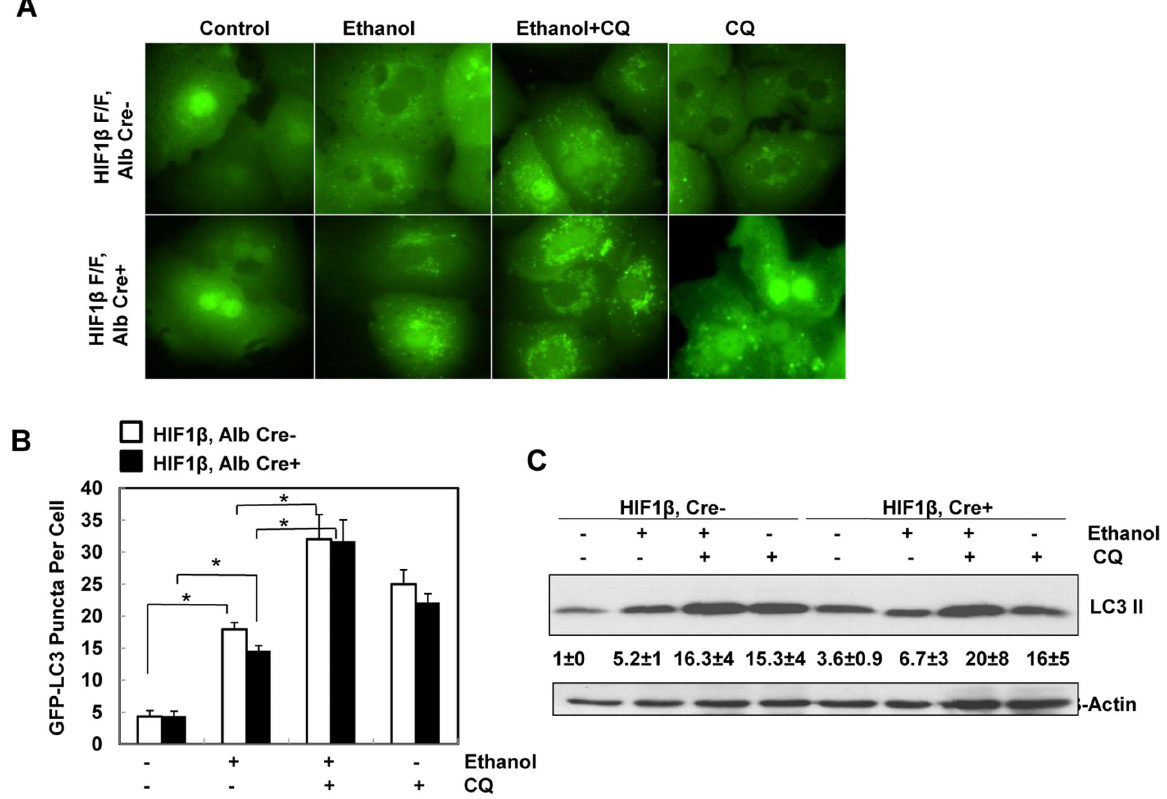
Fig. 3. Ethanol induced autophagic flux in primary mouse hepatocytes independent of HIF-1 b . Primary cultured wild type and HIF-1 b knockout mouse hepatocytes were infected with Ad-GFP-LC3 (100 viral particles per cell) overnight followed by ethanol (80 mM) treatment with or without CQ (20 m M) for 6 hours. ( A ) Representative fluorescence images of GFP-LC3 from each group are shown. ( B ) The number of GFP-LC3 puncta per cell was quantified (more than 20 cells were counted from each independent experiment) and data are presented as means ¡ SE (n 5 3 independent experiments). * p , 0.05. One way ANOVA analysis with Scheffe´’s post hoc test. ( C ) Cells were treated as in ( A ), total cell lysates were subjected to western blot analysis. Densitometry was performed and data are presented as a ratio of HIF-1 b , Alb Cre- control (n 5